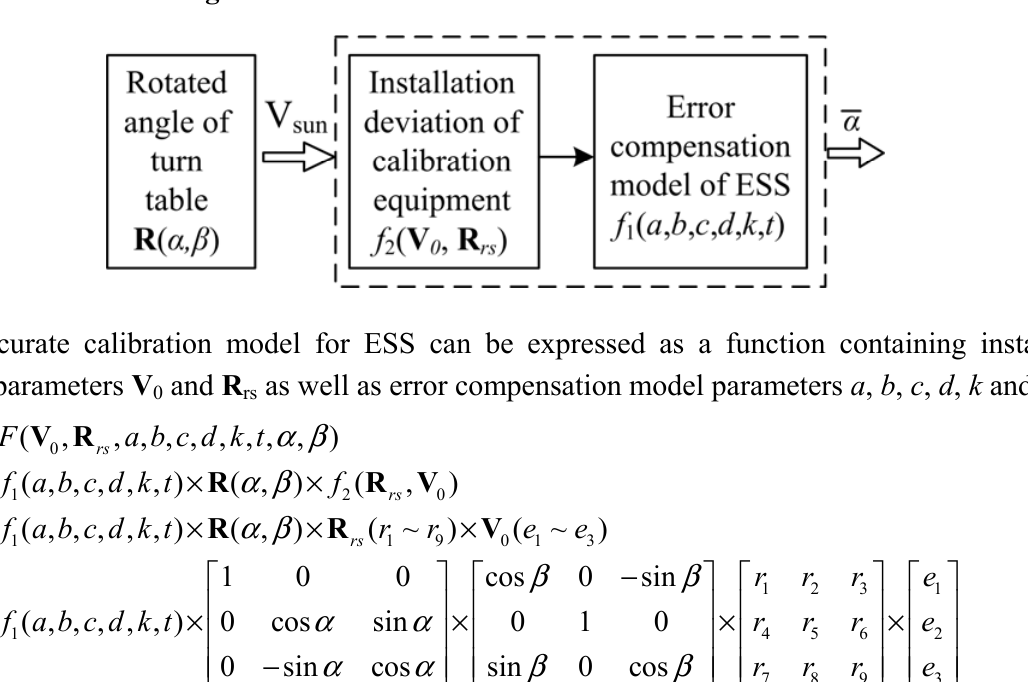
Figure 10. Parameters in the ESS calibration